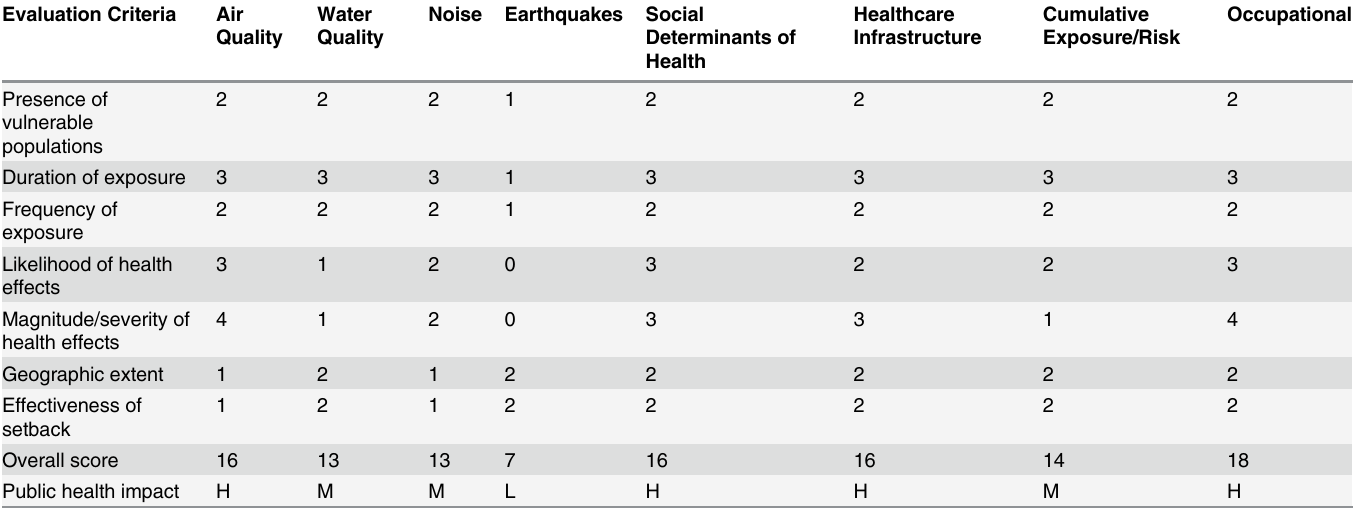
Table 2. Overview of Hazard